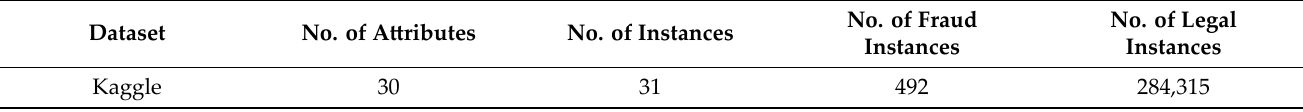
Table 1. Credit card dataset (sourced from Kaggle.com).